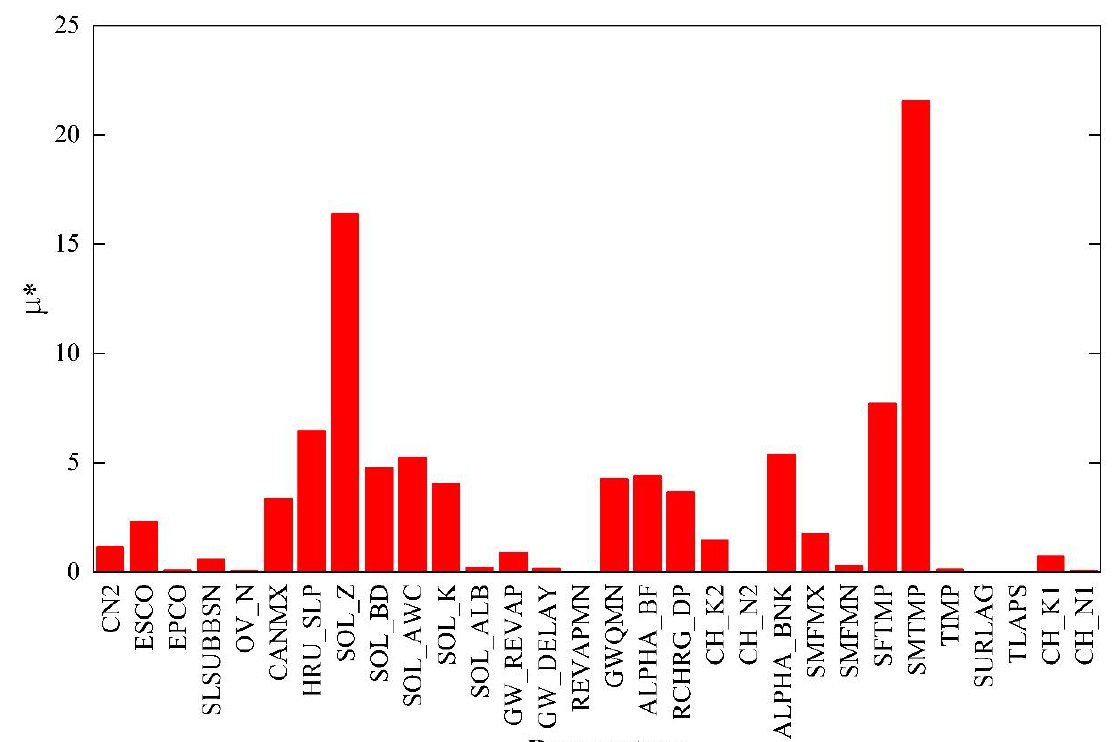
Figure 4. Modified mean ( 𝜇 ∗ ) of each parameter of the Morris screening method.